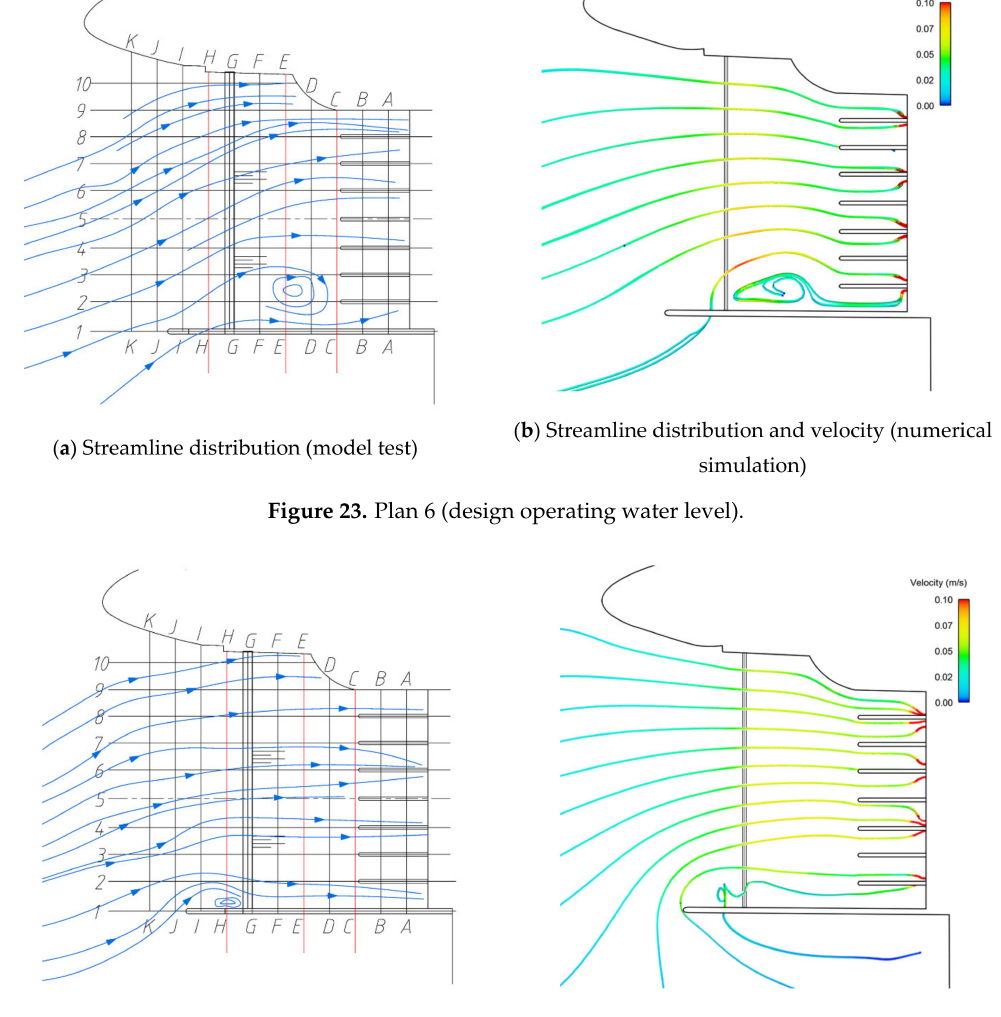
Figure 22. Plan 5 (flood control water level).